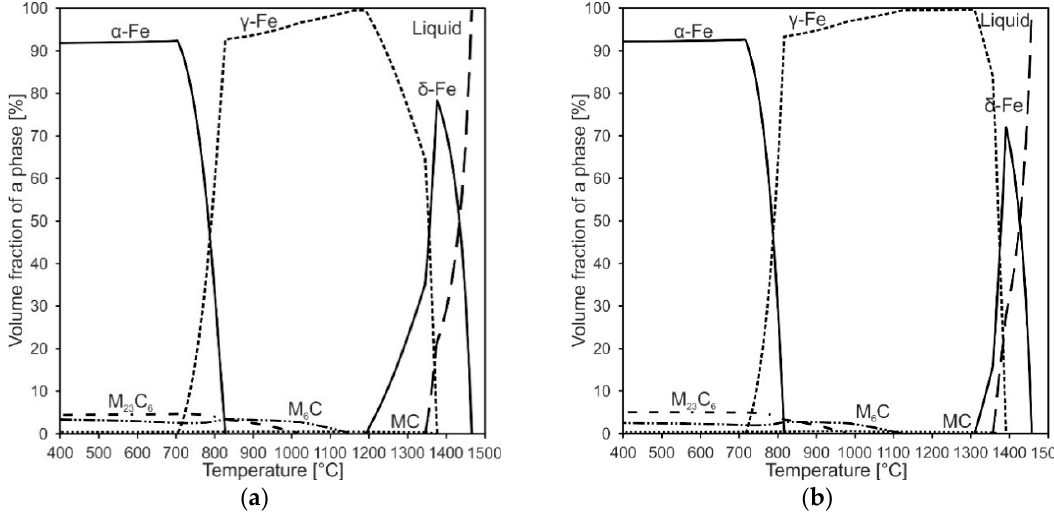
Figure 6. Calculated equilibrium phase fractions of tool steel X36 for nominal chemical composition ( a ) and EDS measured chemical composition ( b ).